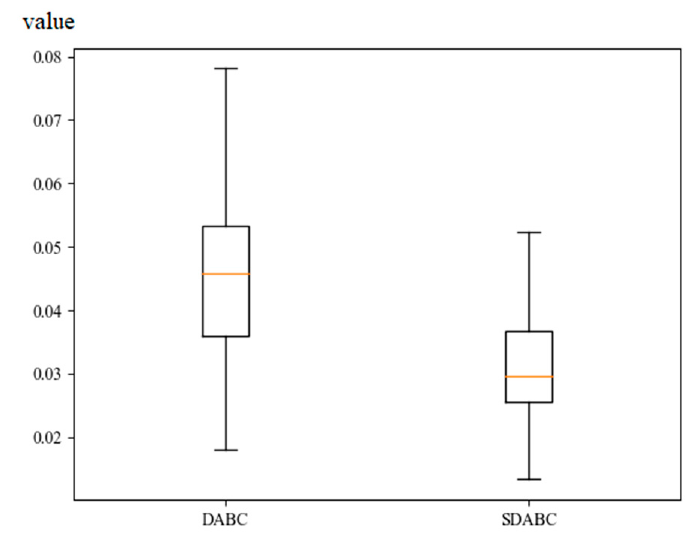
Figure 3. IGD -metric boxplot for DABC and SDABC. This indicates that the solutions obtained by SDABC are better than DABC in terms of diversity and convergence. This is due to the design of five different directions in the search phase, which improves the diversity of solutions obtained. The employed bee improved the convergence by searching around individuals based on the number of dominant solutions and the similarity of ideal